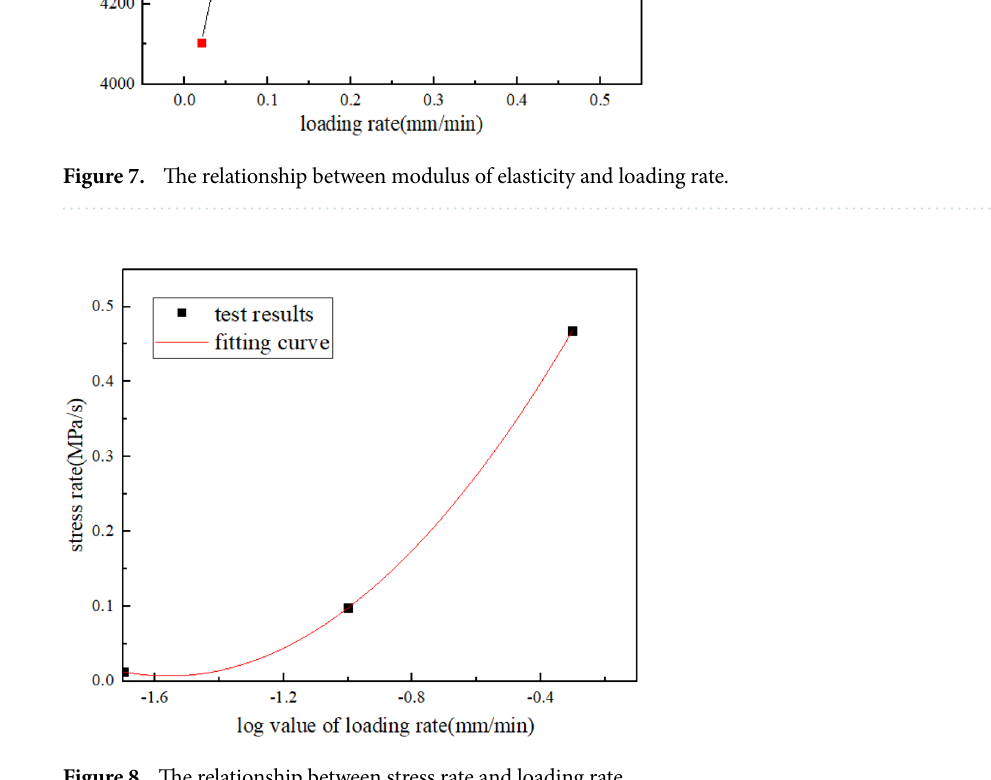
Figure 8. The relationship between stress rate and loading rate.